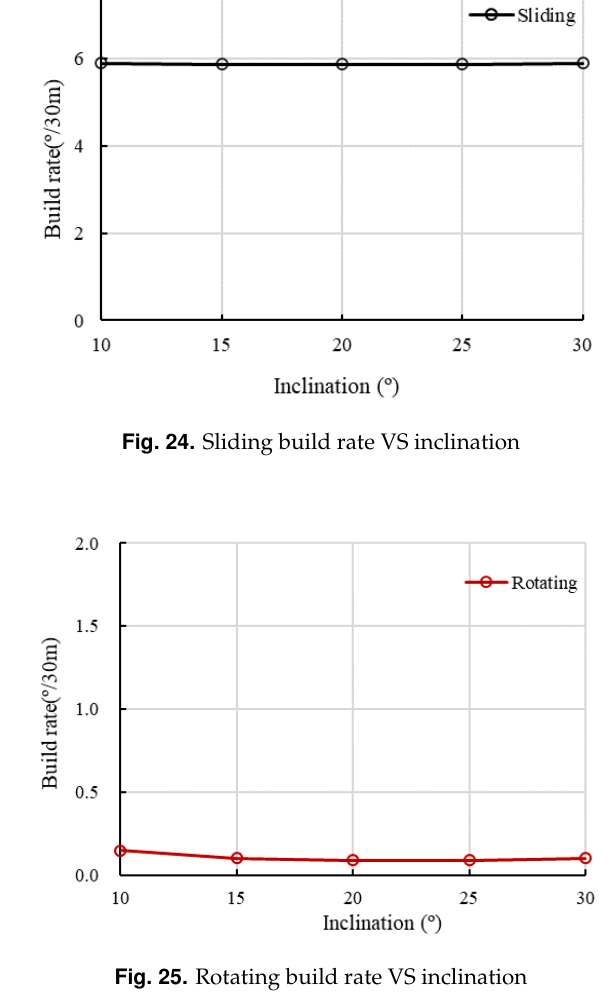
Fig. 25. Rotating build rate VS inclination